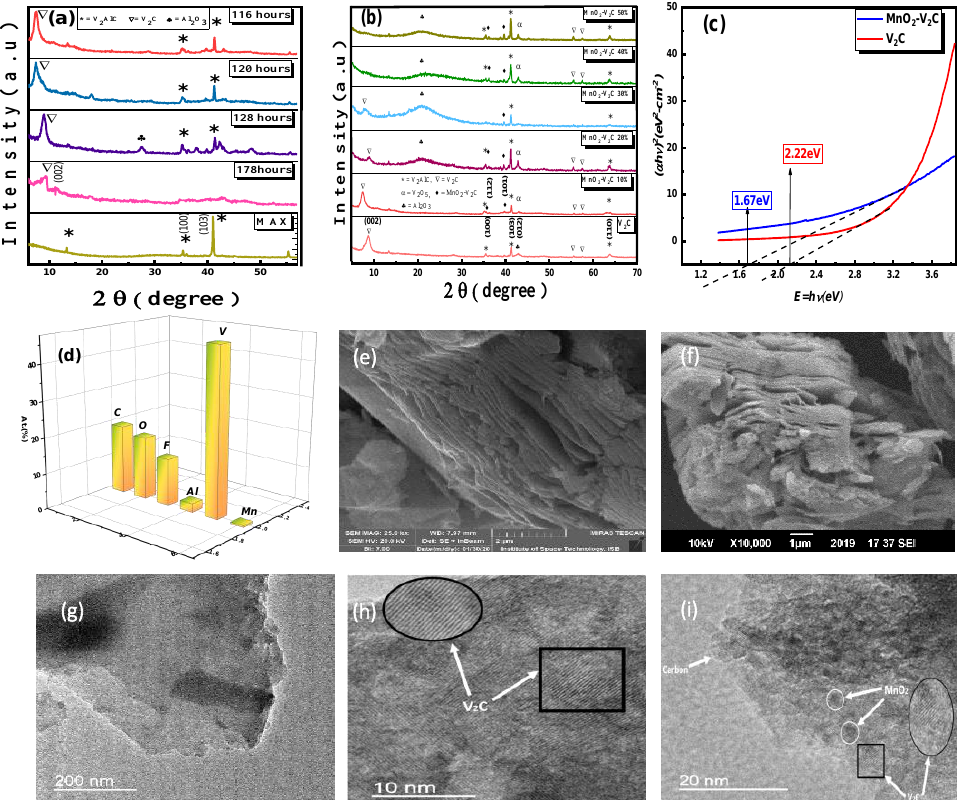
Figure 1. ( a ) XRD of pristine V 2 AlC and prepared V 2 CT x etched for varying time periods, ( b ) XRD of V 2 C MXene nanocomposites with varying weight percentages of MnO 2 , ( c ) bandgap analysis of V 2 C and MnO 2 -V 2 C nanocomposite, ( d ) EDX for the elemental analysis of MnO 2 -V 2 C nanocomposite, ( e ) micrograph for pristine V 2 C, ( f ) micrograph for MnO 2 -V 2 C nanocomposite. ( g ) TEM image of V 2 C at 200 nm, ( h ) TEM image of V 2 C at 10 nm, ( i ) TEM image of MnO 2 -V 2 C nanocomposite.